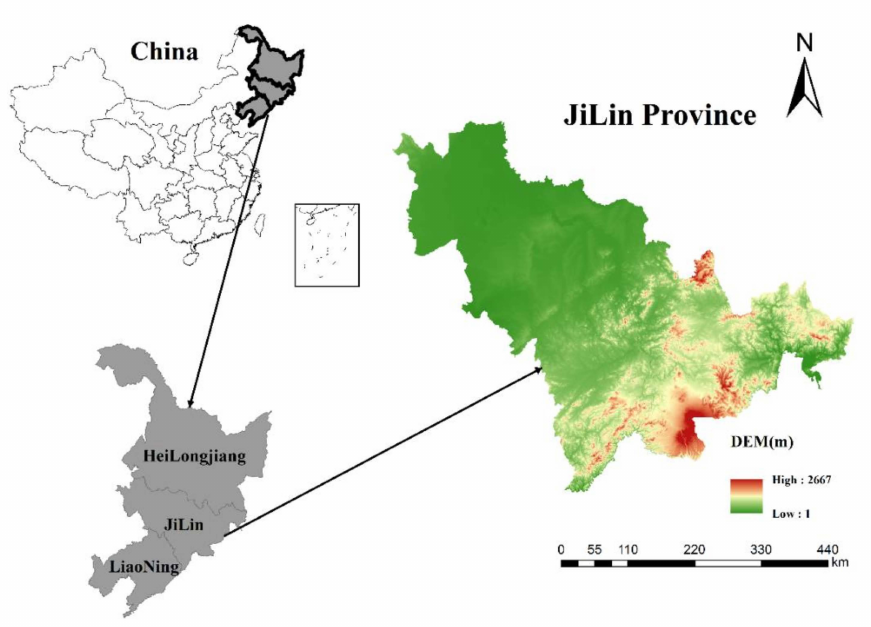
Figure 1. The map of study area depicts the location of Jilin province and presents the elevation